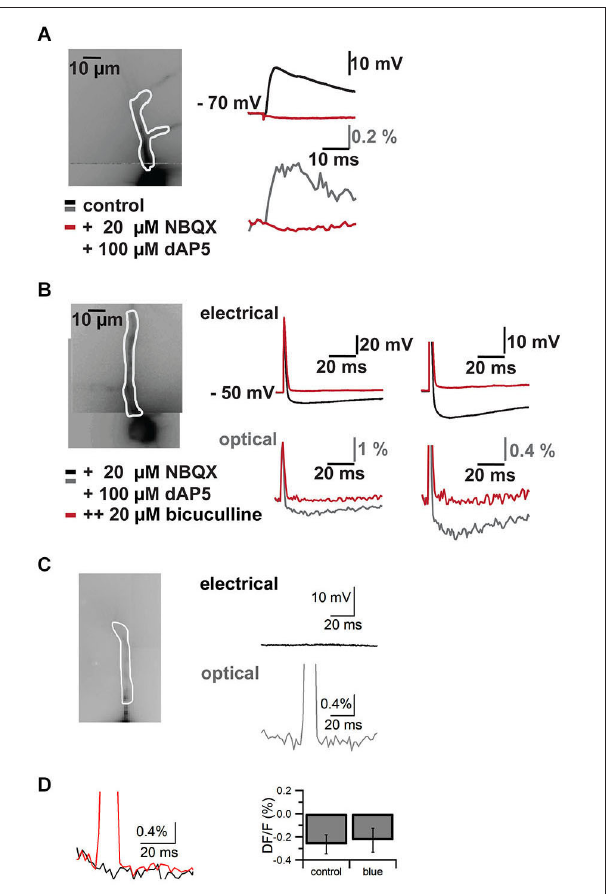
FIGURE 4 | Control experiments . Pharmacological block of synaptic signals in cells filled with VSD and blue laser artifact in the absence of an electrical response. Responses are recorded both with somatic patch clamp electrodes (top traces in mV) and by VSD imaging (bottom traces in% DF/F). (A) Imaged neuron with ROI on apical dendrite shown in white outline on the left. On the right EPSP through the somatic patch clamp electrode top and VSD imaging in the region of interest bottom. Black/gray traces are baseline, red traces are after addition of the NMDA and AMPA receptors AP5 and NBQX respectively. (B) Imaged neuron with region of interest on apical dendrite in white outline on the left. A stimulus electrode was placed near the soma of the neuron to evoke an action potential and an inhibitory postsynaptic potential (excitatory synaptic transmission was blocked with AP5 and NBQX). Traces on the right show electrode recordings on top and VSD imaging at bottom at lower (left) and higher resolution (right). Black/gray are baseline traces, red traces are after application of the GABA(A) receptor antagonist bicuculline. Note that the action potential is preserved and faithfully recorded by VSD, while the inhibitory synaptic signal is completely blocked by the GABA(A) receptor antagonist. I four such cells we could completely block synaptic signals with a combination of AP5, NBQX and bicuculline. (C) Imaged neuron with region of interest overlaid on the left. Electrical recording (top, black) and optical recording (bottom, gray) from a CA1 pyramidal neuron. The focused laser beam failed to hit ChR2 expressing structures and thus failed to elicit a response. A square pulse artifact can be observed in the optical trace. (D) Left, overlay of trace without laser stimulation (black) and with laser stimulation (red) in the absence of a synaptic response. The decay in the response is due to dye bleaching, which was not compensated in this case. To quantify the effect of the blue laser pulse in the absence of synaptic responses, we measured the difference between two 5 ms epochs, one 5 ms ( Continued